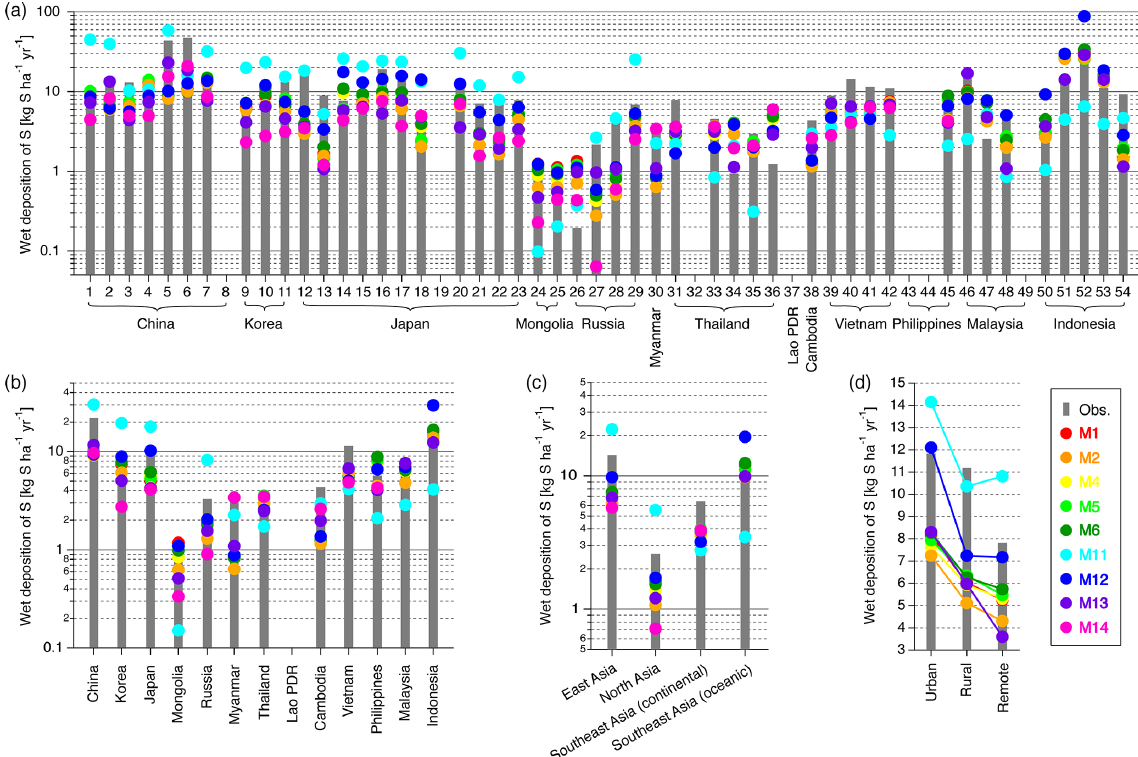
Figure 3. Model evaluation of the annual accumulated wet deposition of sulfate aerosol, sulfur dioxide (SO 2 ), and sulfuric acid (H 2 SO 4 ) (S) (a) at each EANET observation site, (b) for countries, (c) over four defined regions, and (d) over different site